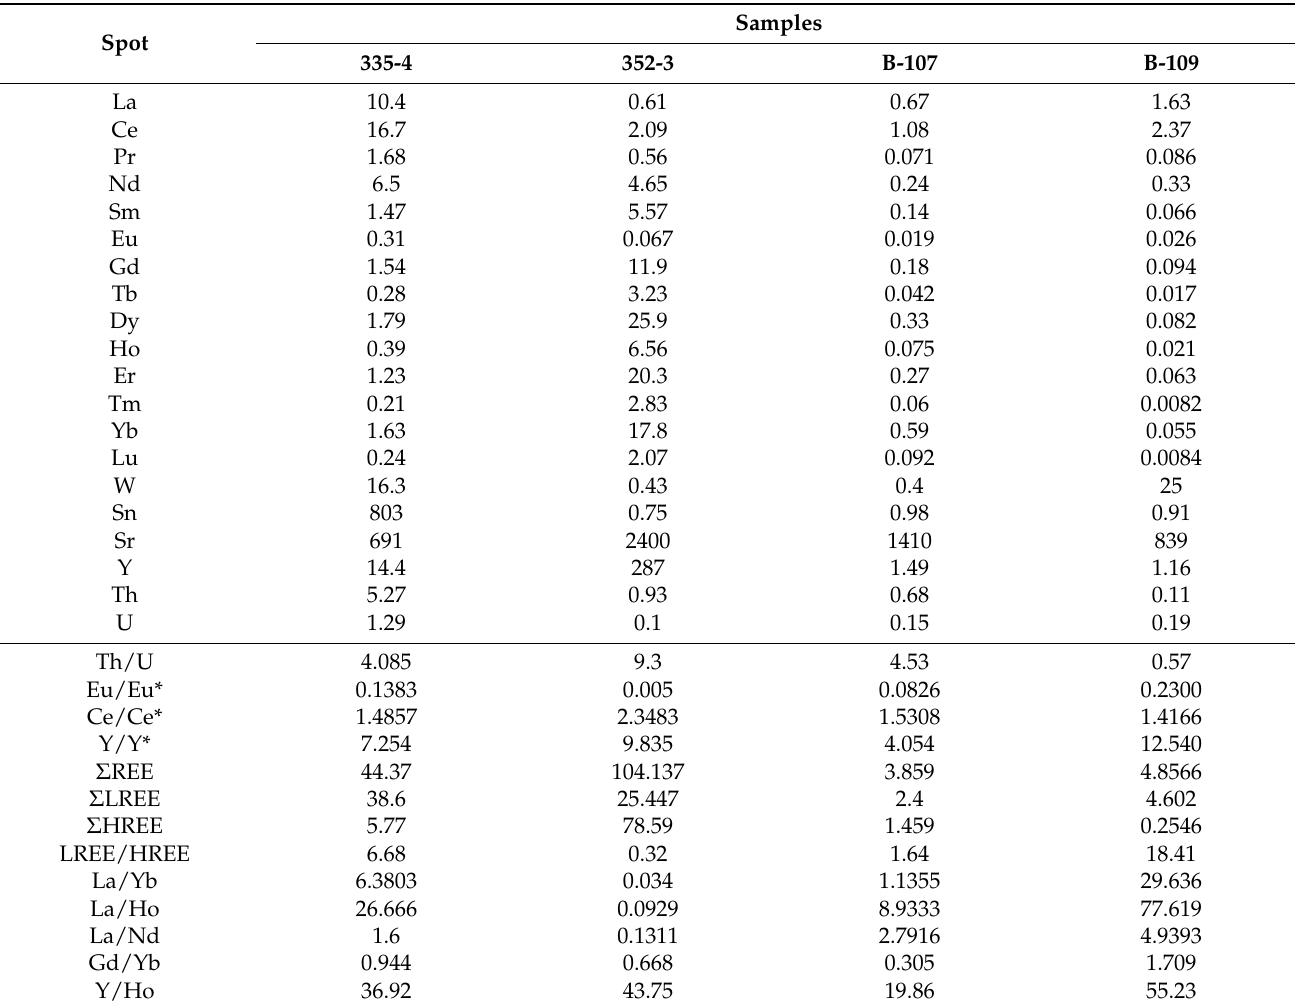
Table 4. Rare element and trace element concentrations (ppm) in fluorites of various types from Voznesenskoe deposit.